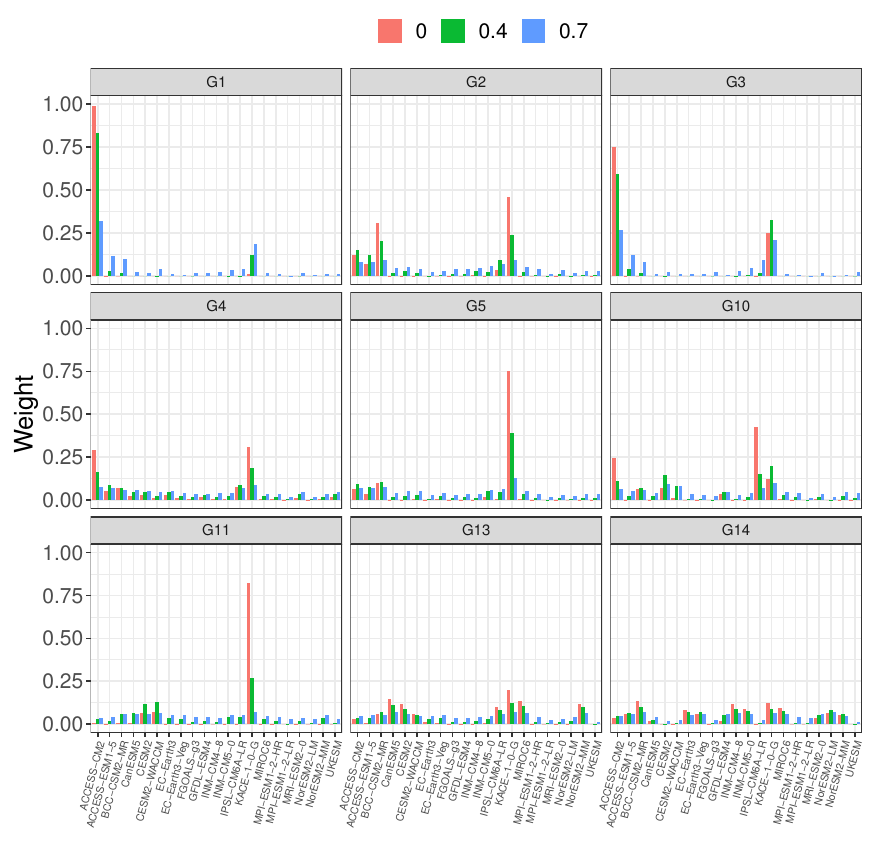
Figure 3. Distributions of the weights obtained from various α -corrections for for some grid cells. Red, green, and blue bars represent the α -weights with α = 0, 0.4, and 0.7,